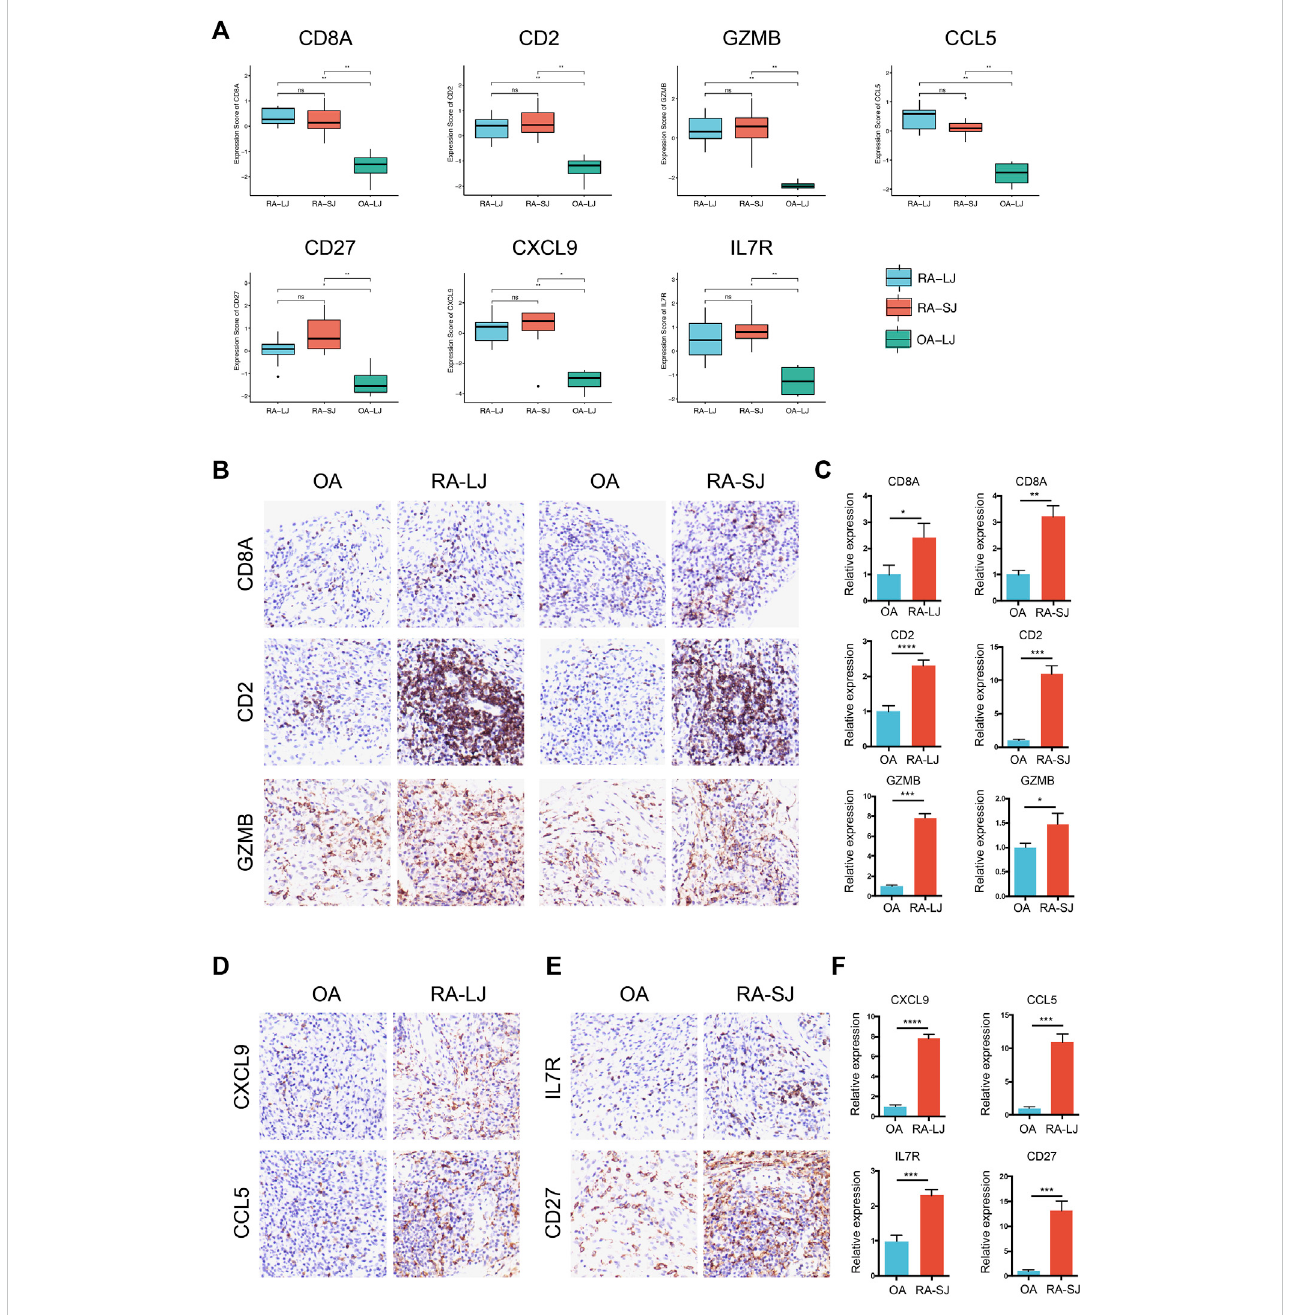
FIGURE 5 Expressions of hub genes in different groups in the microarray datasets and validations by immunohistochemical staining using joint biopsy sections. (A) Expressions of hub gene CD8A , CD2 , GZMB , CCL5 , CXCL9 , IL7R, and CD27 in RA-LJ, RA-SJ, and OA samples (B) – (F) The protein expressions of the 7 hub genes were determined by immunohistochemical staining using joint samples from patients. * p -value < 0.05.** p -value < 0.01. *** p -value < 0.001. **** p -value < 0.0001. Ns, no signi fi